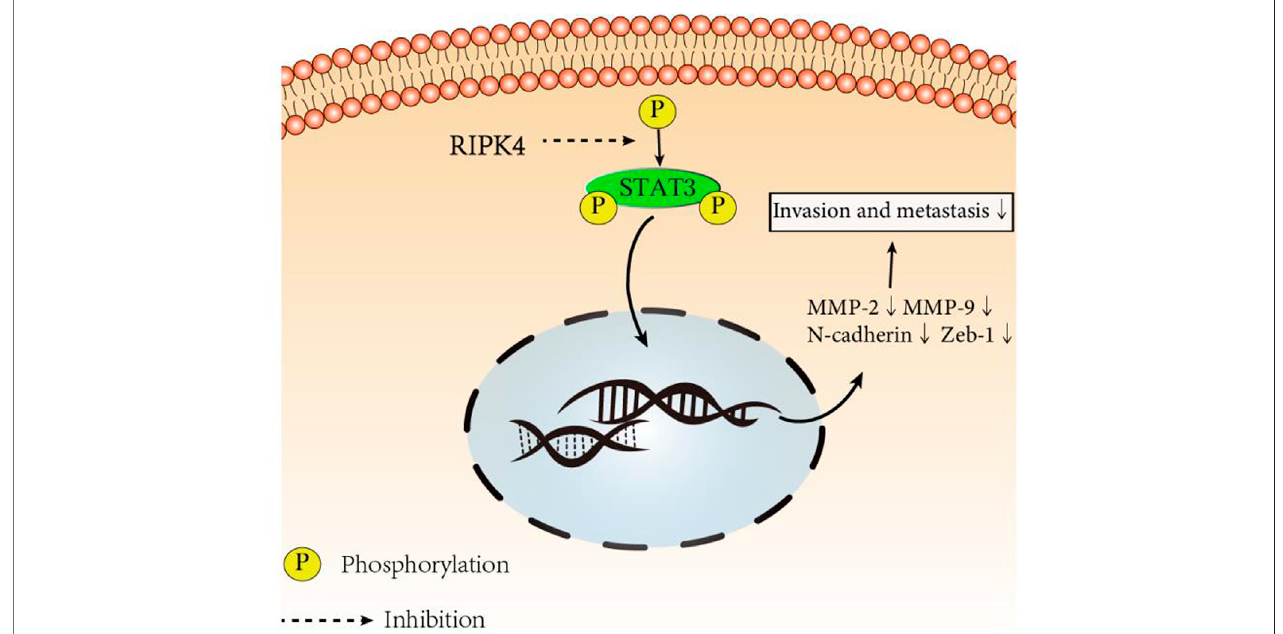
FIGURE 6 | RIPK4 inhibits the invasion and metastasis of hepatocellular carcinoma by mediating the STAT3 signal pathway.